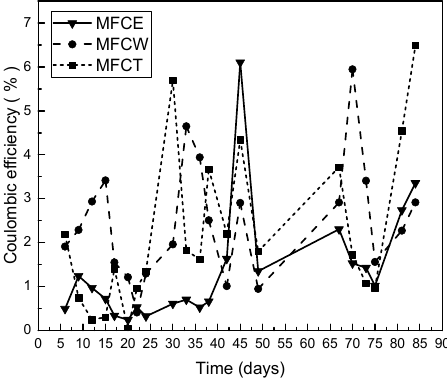
Figure 5. Coulombic efficiency on the MFC.